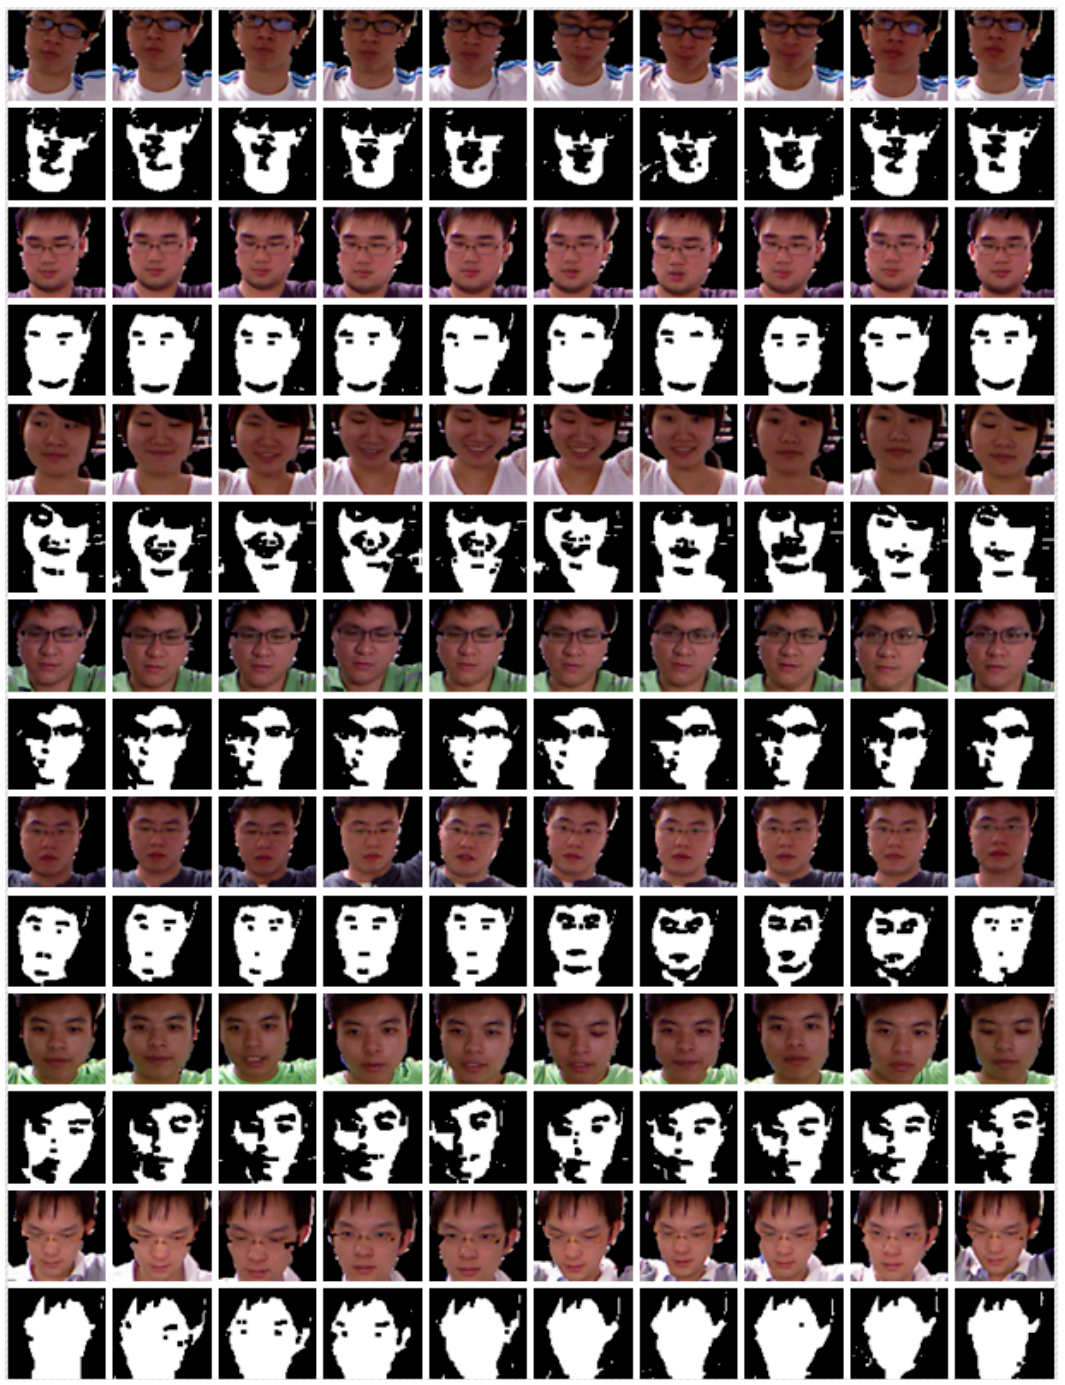
Figure 15. Results of test samples 1–7.